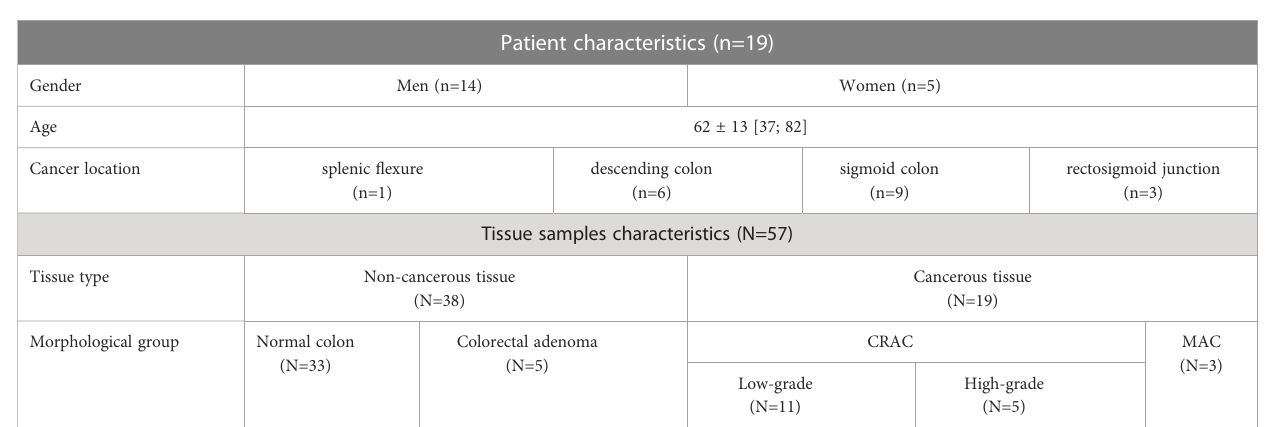
TABLE 1 Clinical and pathological characteristics for the examined cohort.